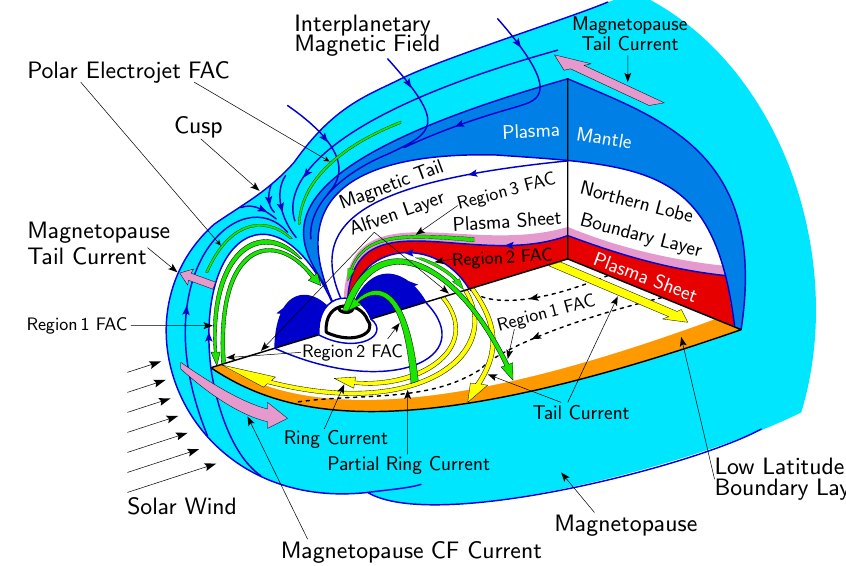
Fig. 16. The 3-D system of electric currents in the magnetosphere during a magnetic storm.